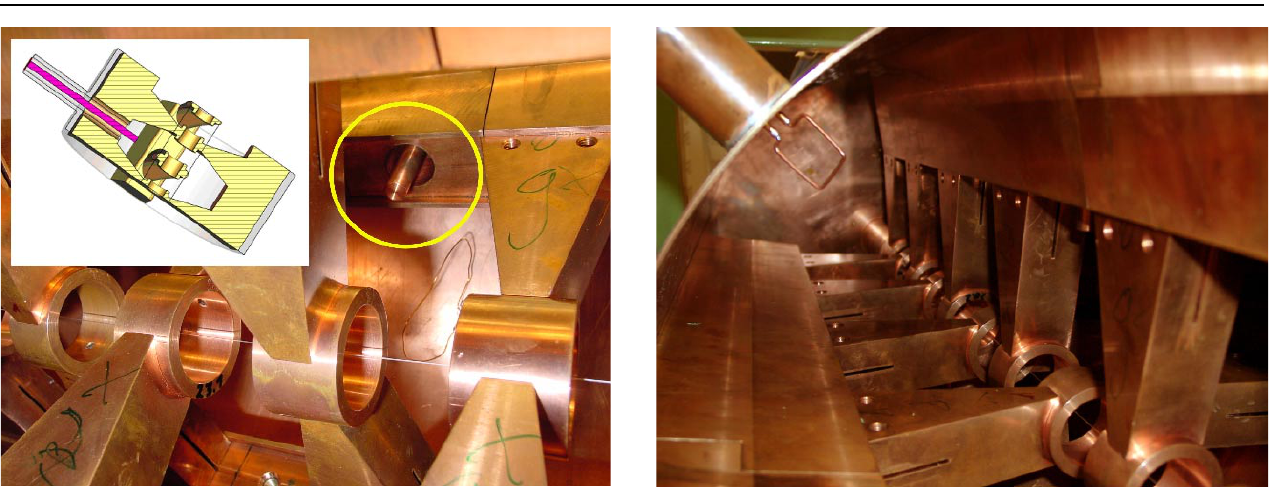
FIG. 16. (Color) The picture shows the location of the inductive coupler in the room temperature copper model. The external Q -value has been varied by changing the loop angle.